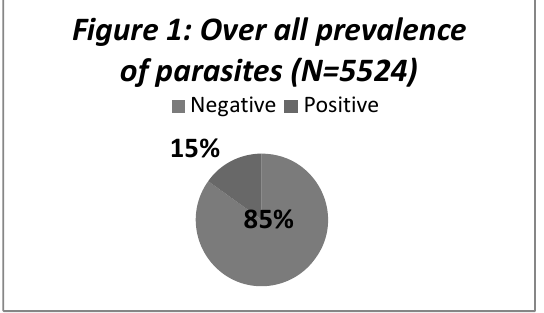
Figure 1: Over all prevalence of parasites (N=5524) Negative Positive 85%15%